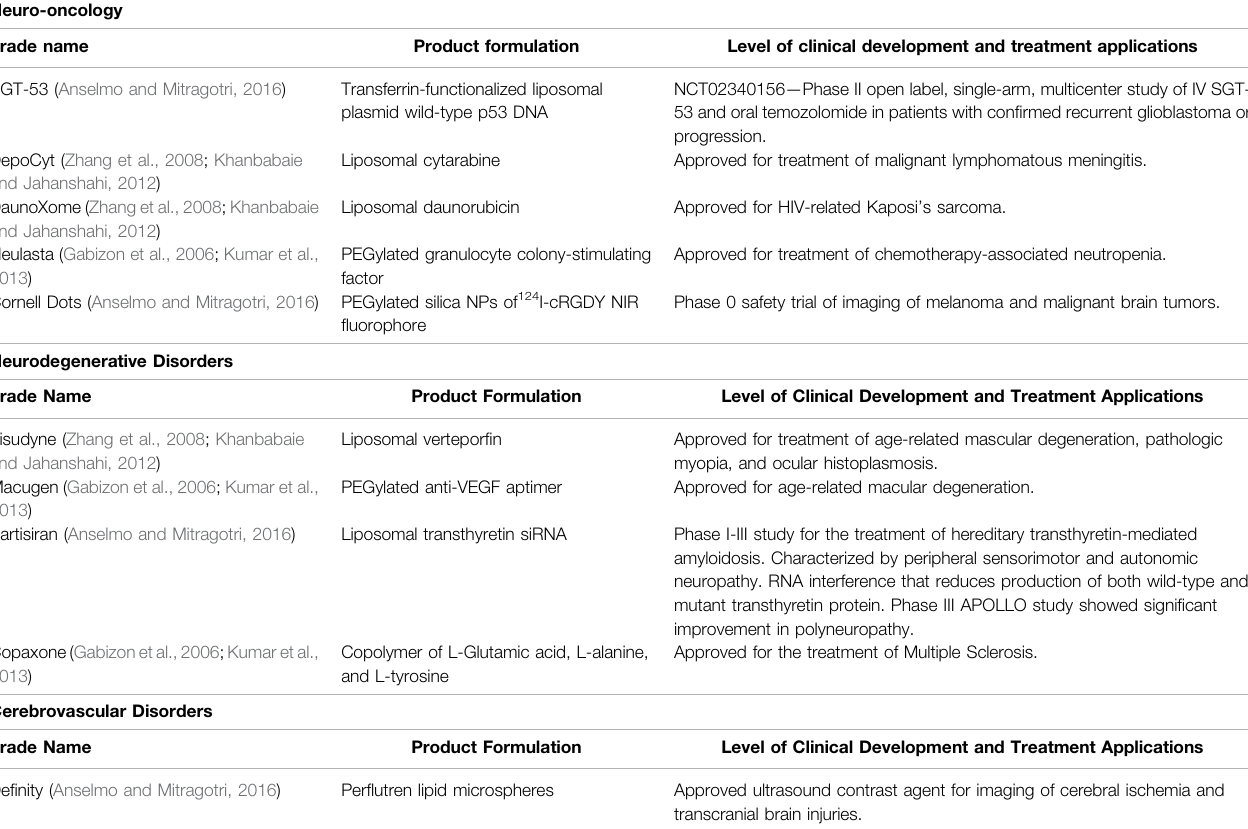
TABLE 1 | Nanoparticles approved or currently in clinical trials for neurological diseases. List of nanoparticles that are in human clinical trials or have been approved for the treatment of neuro-oncologic, neurodegenerative, and cerebovascular disorders.